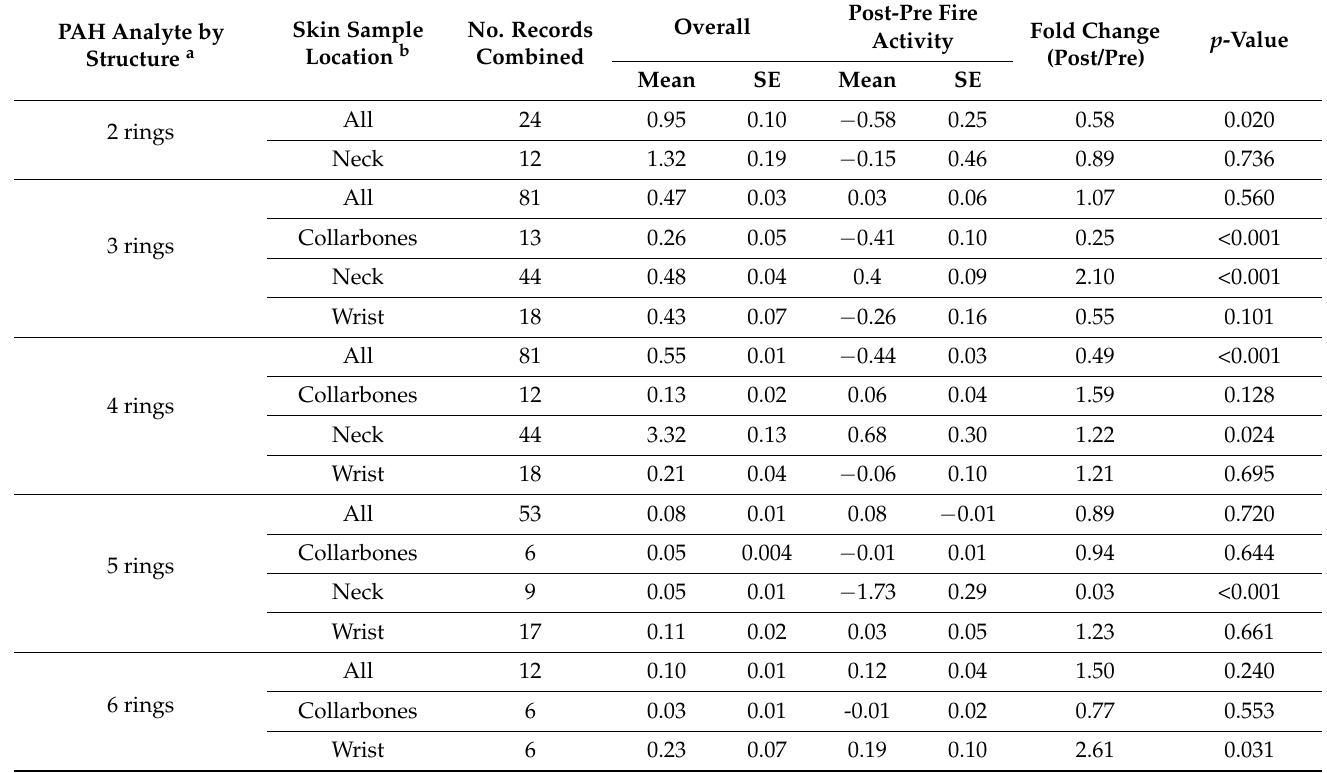
Table 3. Pre/post comparison of PAH collected from wipe-on-skin samples by structure (unit: ng/cm 2 ). Bold p -value indicates statistically significant dermal exposure increased after the fire activity. PAH Analyte by